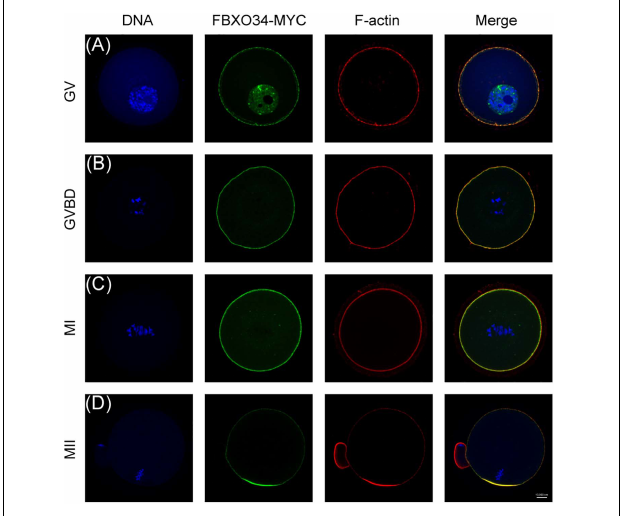
FIGURE 1 | Subcellular localization of FBXO34 in oocyte meiotic stages. (A–D) Oocytes at GV, GVBD, MI, and MII stages were collected for immunofluorescent analysis for FBXO34 (green), DNA (blue), and F-actin (red). Scale bar, 10 µ m.